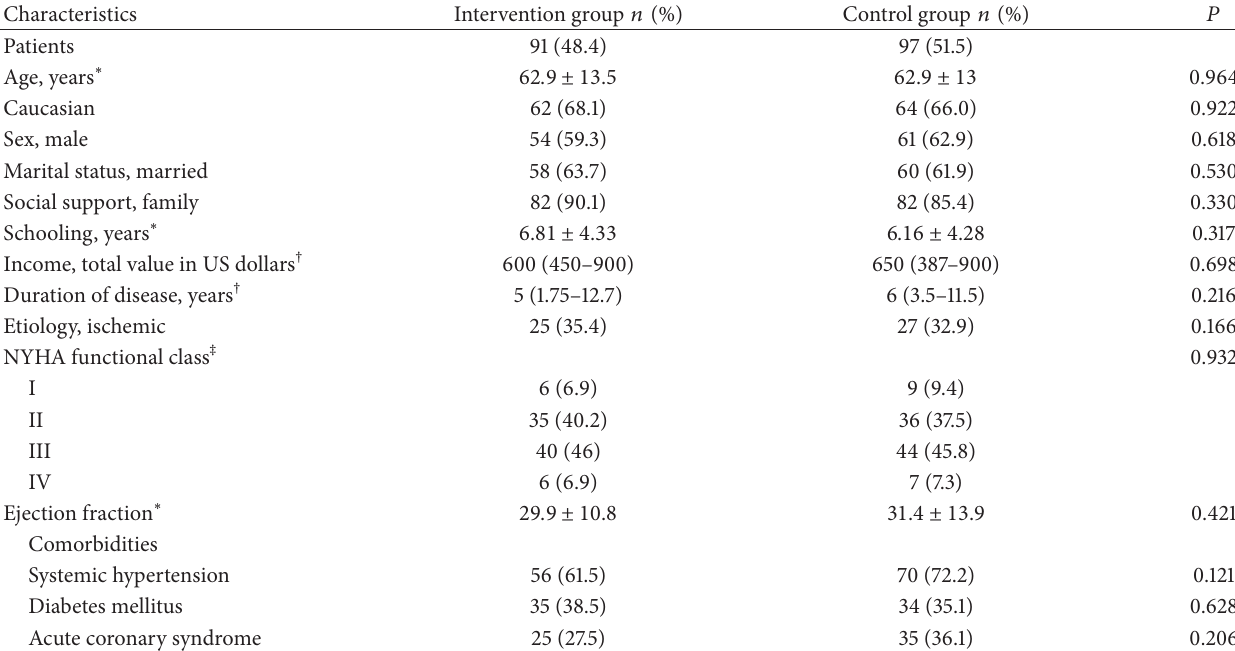
Table 1: Sociodemographic and clinical characteristics ( 𝑛 = 188 ).